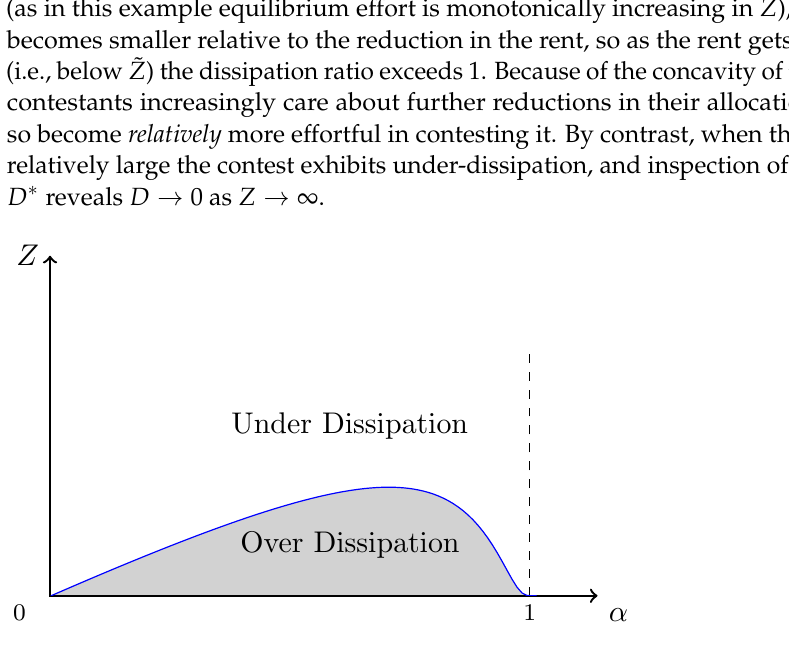
Figure 1. This illustrates the critical threshold of rent, ˜ Z , under which over-dissipation of the rent will occur, plotted as a function of α which controls the degree of concavity of